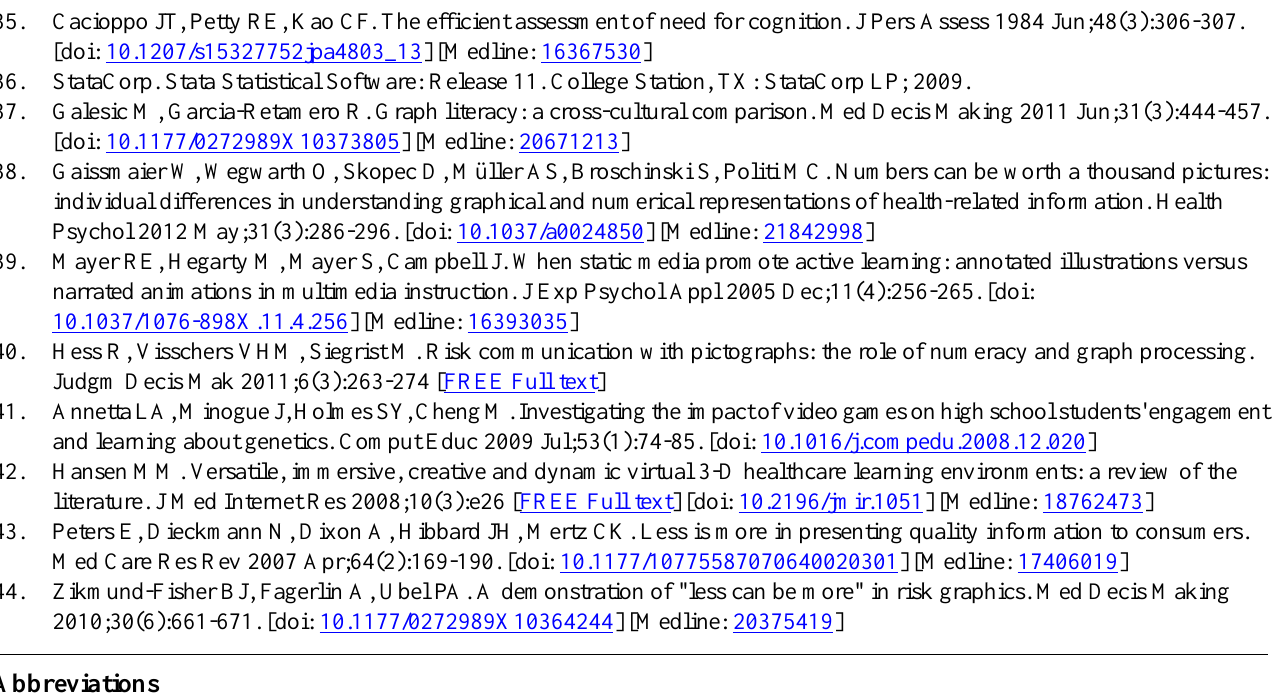
Abbreviations SNS: Subjective Numeracy